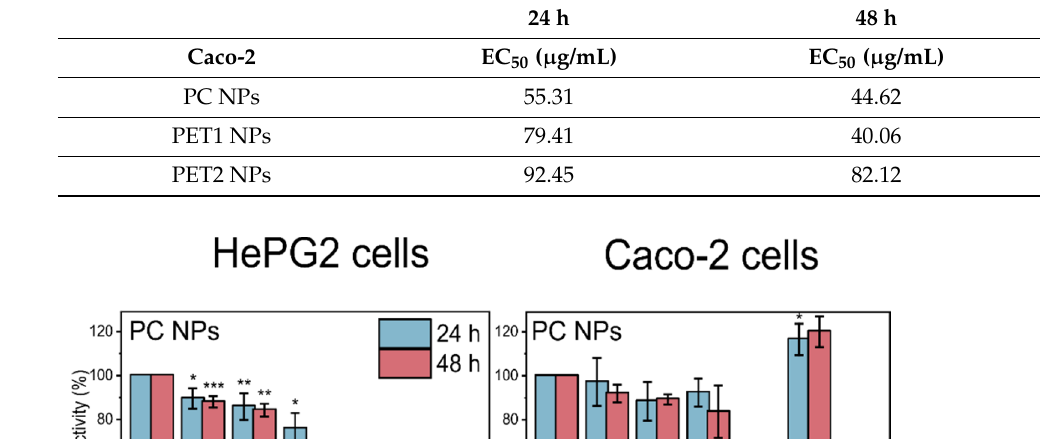
Table 1. The table reports EC 50 values (µg/mL) for HePG2 and Caco-2 cells exposed to PC, PET1, and PET2 NPs at 24 or 48 h.